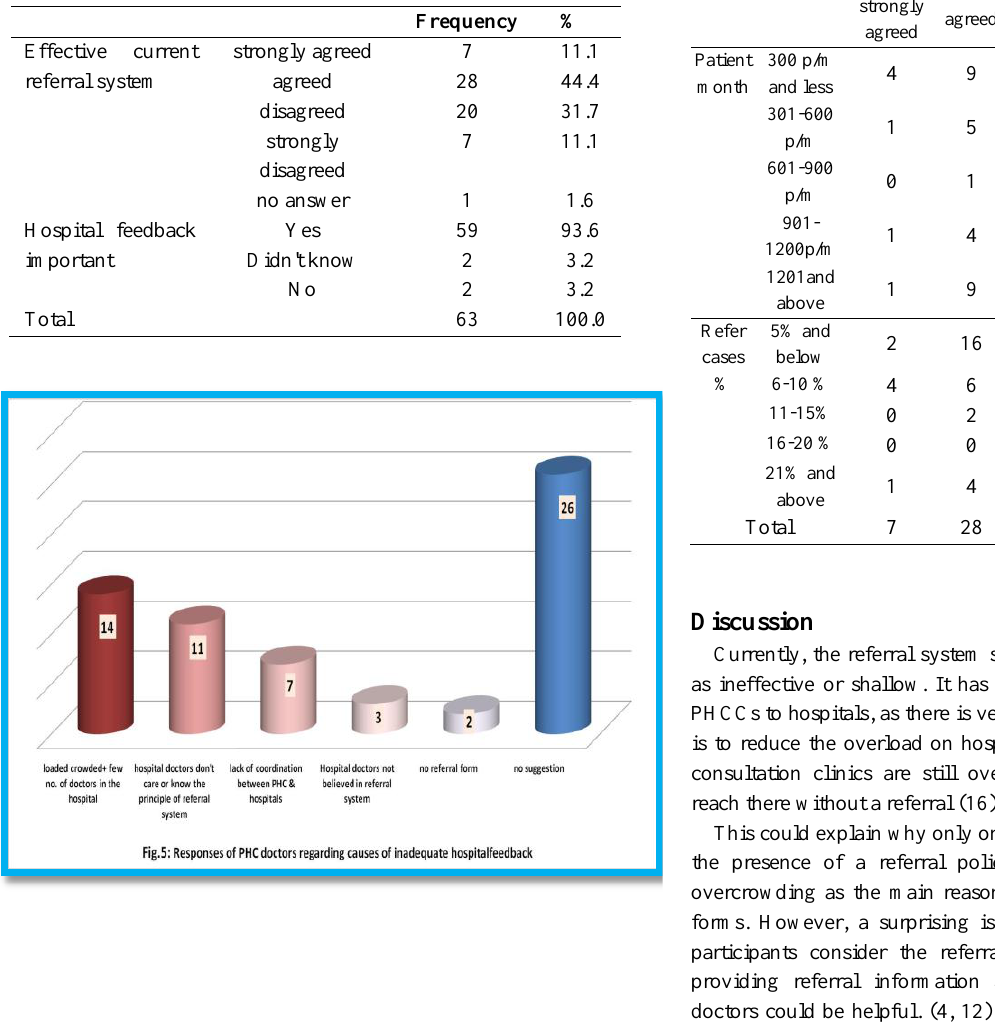
Table 5: Distribution of participant doctors according to their perception about the effectiveness of current referral system & the important of hospital feedback.